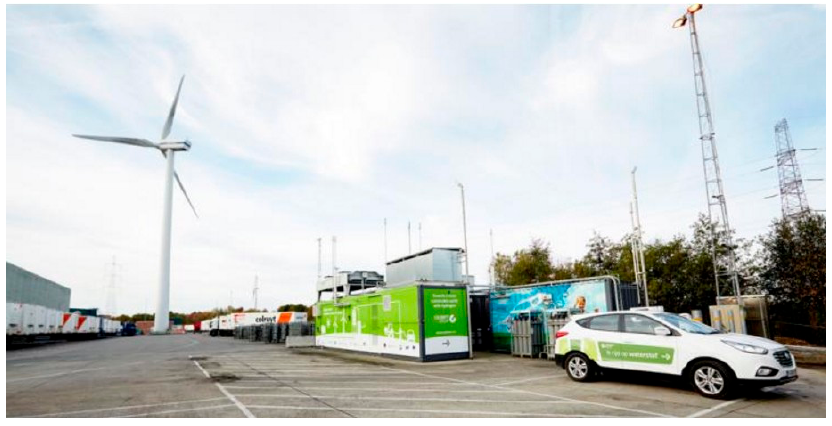
Figure 2. The Don Quichote station in Halle.